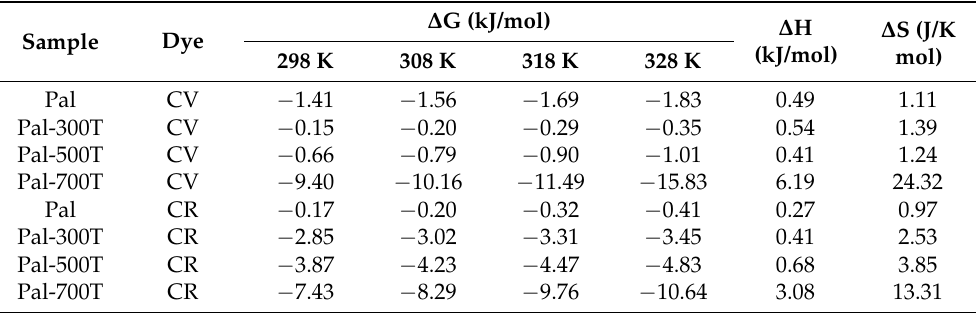
Table 5. Thermodynamic parameters for CV and CR adsorption in palygorskite before and after heat treatment at different temperatures.